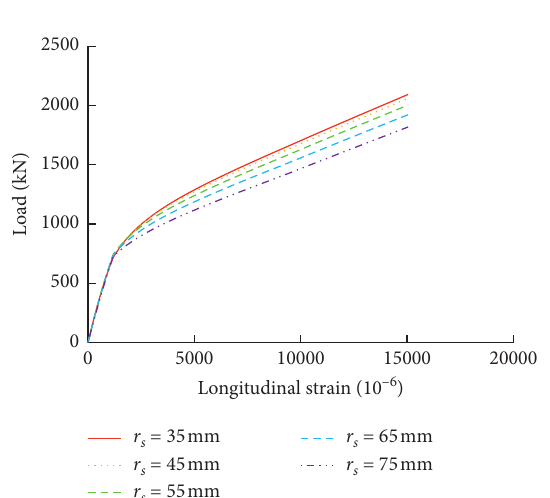
Figure 13: Effect of outer radius of the steel